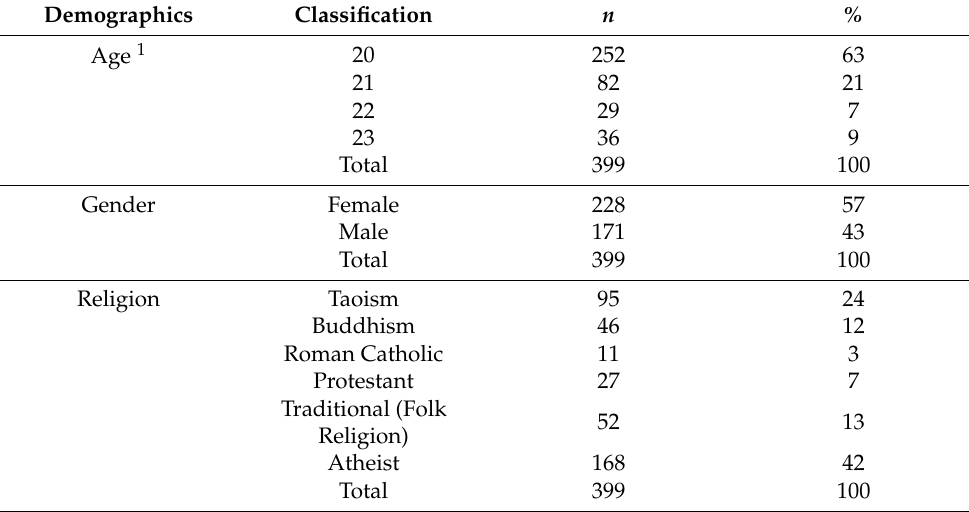
Table 1. Demographic profile of the